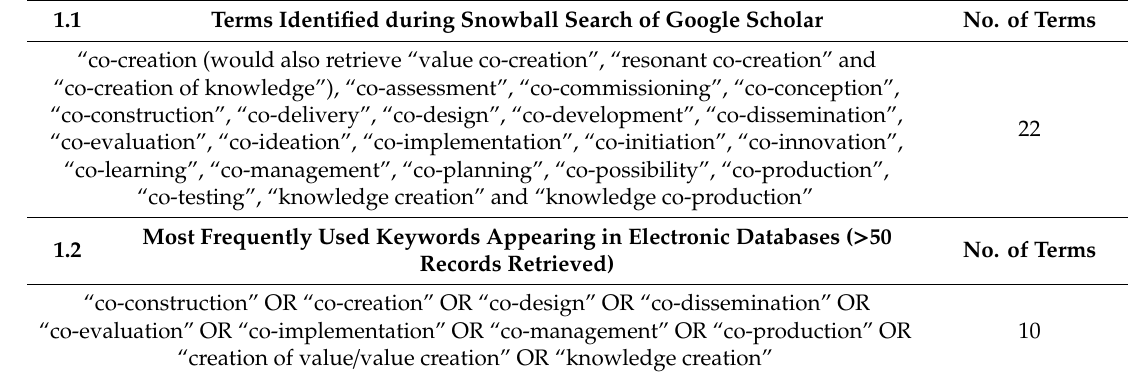
Table 1. Co-creation-related